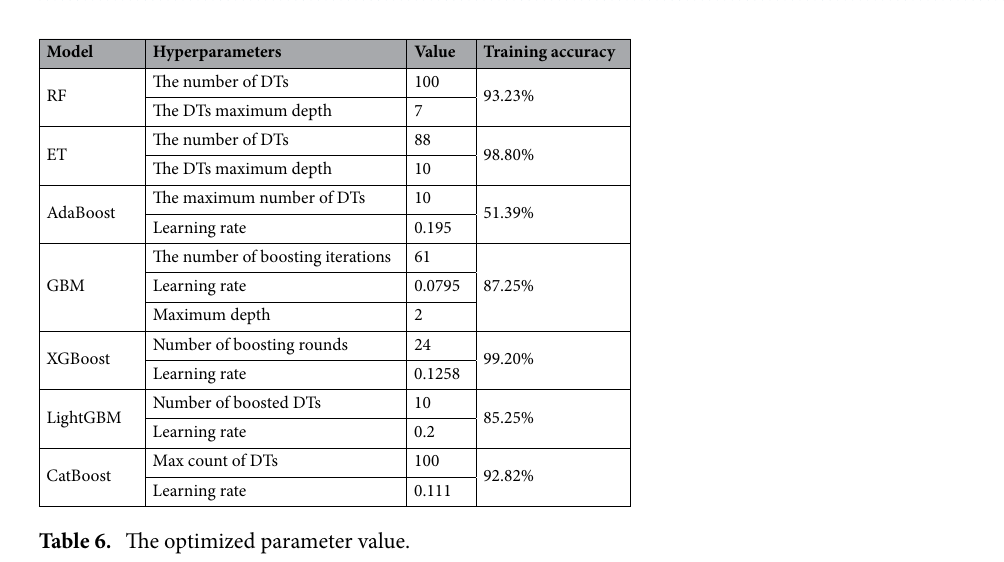
Figure 7. The iterative convergence of the objective function.